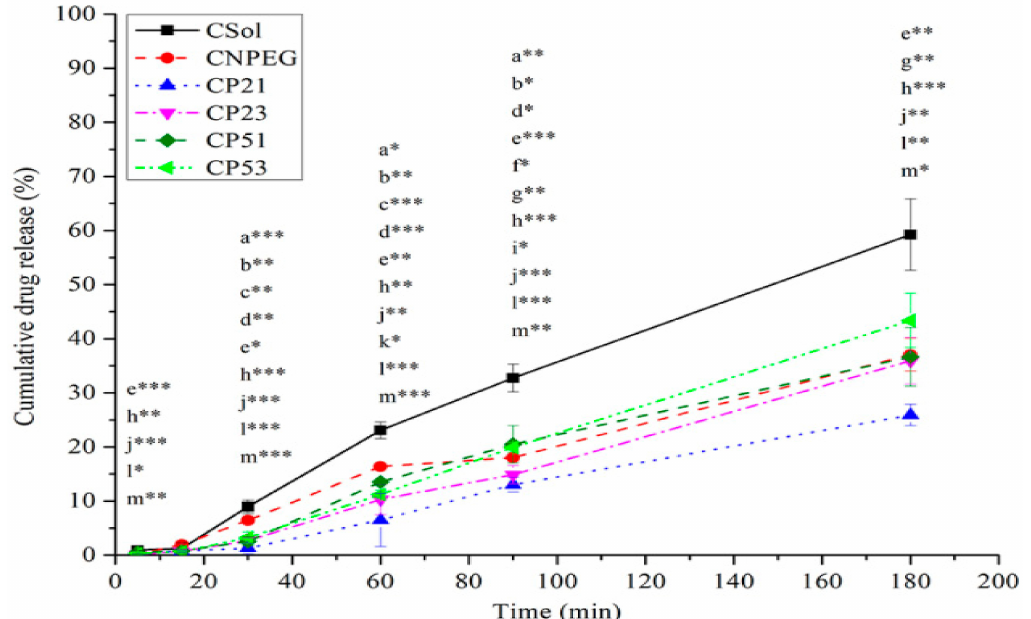
Figure 6. Cumulative % of curcumin released from loaded formulations (t = 37 ◦ C). Values are displayed as means ± sd ( n = 3); a* p < 0.05, a** p < 0.01, a*** p < 0.001, CNPEG vs. CP21; b* p < 0.05, b** p < 0.01, CNPEG vs. CP23; c** p < 0.01, c*** p < 0.001, CNPEG vs. CP51; d* p < 0.05, d** p < 0.01, d*** p < 0.001, CNPEG vs. CP53; e* p < 0.05, e** p < 0.01, e*** p < 0.001, CNPEG vs. CSol; f* p < 0.05, CP21 vs. CP51; g** p < 0.01, CP21 vs. CP53, h** p < 0.01, h*** p < 0.001, CP21 vs. CSol; i* p < 0.05, CP23 vs. CP53, j** p < 0.01, j*** p < 0.001, CP23 vs. CSol; k* p < 0.05, CP51 vs. CP53; l* p < 0.05, l** p < 0.01, l*** p < 0.001, CP51 vs. CSol; m* p < 0.05, m** p < 0.01, m*** p < 0.001, CP53 vs.